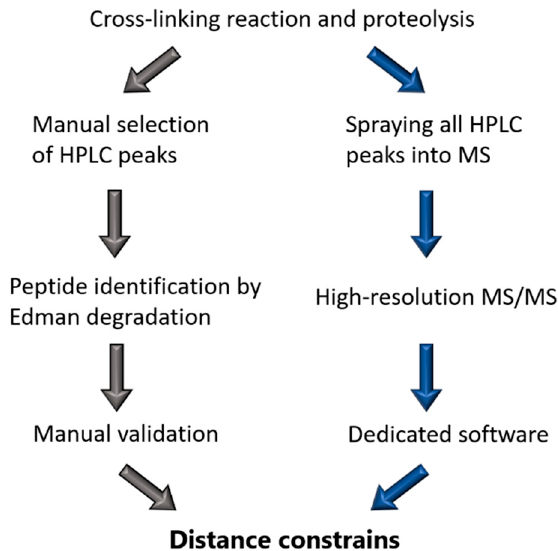
Figure 2. Comparison of cross-linking workflow of Steinert’s group ( left ) and the modern MS based method ( right ).